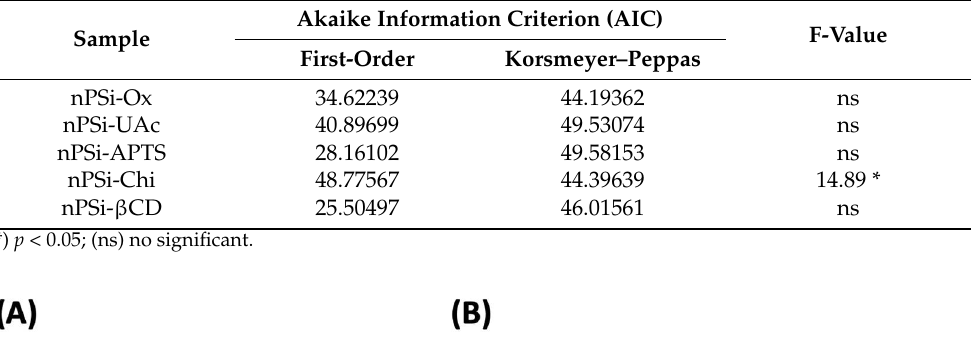
Table 3. Model comparison by AIC and F-Value.